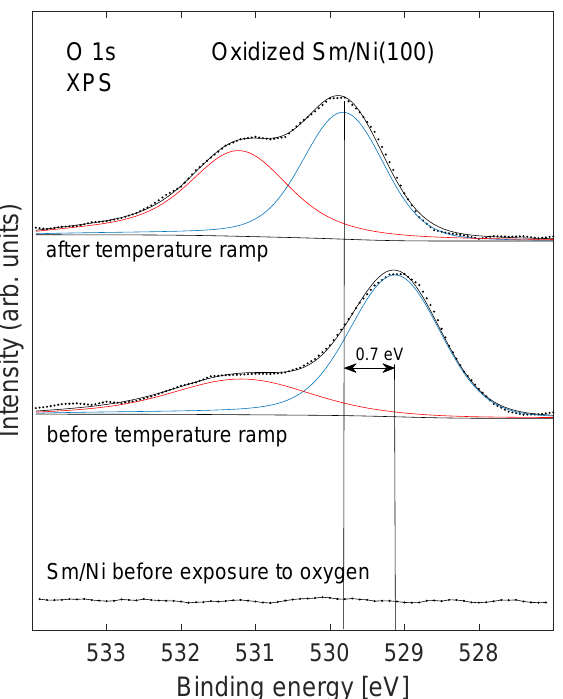
Figure 3. XPS showing the O 1s core level before and after heating to 900 K of an oxidized sample of effective Sm coverage 0.9 ML. A core level shift of the main feature in the spectra of 0.7 eV after heating is indicated in the figure. The bottom curve shows the absence of O 1s emission before exposure to oxygen of the Sm/Ni